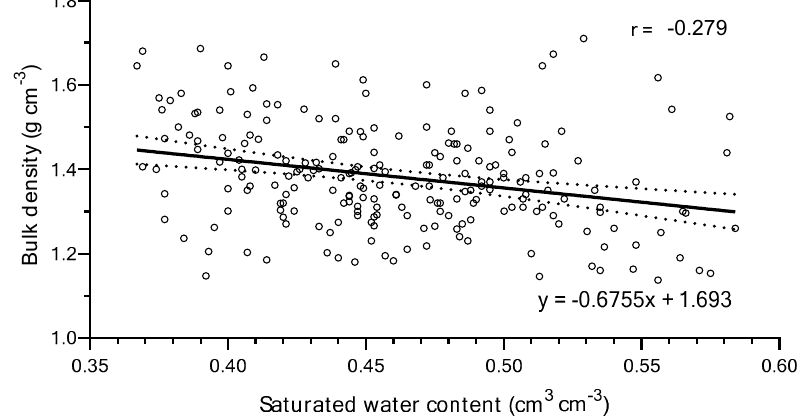
Figure 5. Saturated water content and bulk density as measured on 217 undisturbed topsoil samples during two growing seasons. The gray area represents the 95% confidence interval of the fitted line; r stands for correlation coefficient.